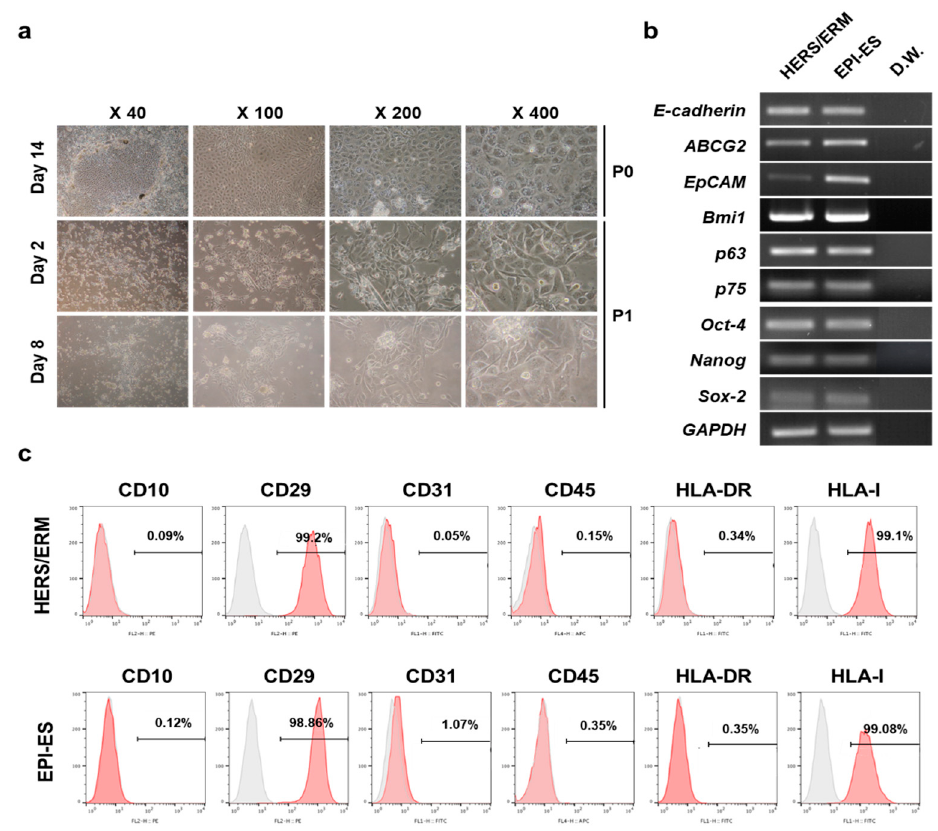
Figure 2. Differentiation of human embryonic stem cells (hESC) into dental epithelial-like stem cells (EPI-ES). ( a ) Morphological change during hESC differentiation into EPI-ES. After 14 days on the feeder layer, typical epithelial cell-like cuboidal- or polygonal-shaped appearances were observed around the hESC clumps. During two to eight days after subculture, cells with these morphologies underwent colony-forming proliferation. ( b ) Gene expression of EPI-ES after 14 days of induction. All samples, as well as HERS/ERM, were positive for epithelial stem cell markers and stemness markers. ( c ) Expression of surface antigens of EPI-ES. Both primary HERS/ERM and all epithelial-like cell lines were positive for mesenchymal markers (CD29) and HLA type I, but negative for hematopoietic cell markers (CD10, CD45, and HLA-DR) and an endothelial cell marker (CD31). All data were replicated three times.